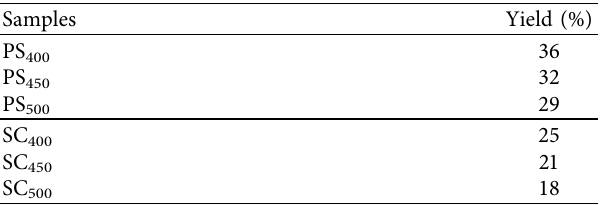
Table 1: Yield of peanut shell and bagasse sugar cane biochar samples prepared at diferent pyrolysis